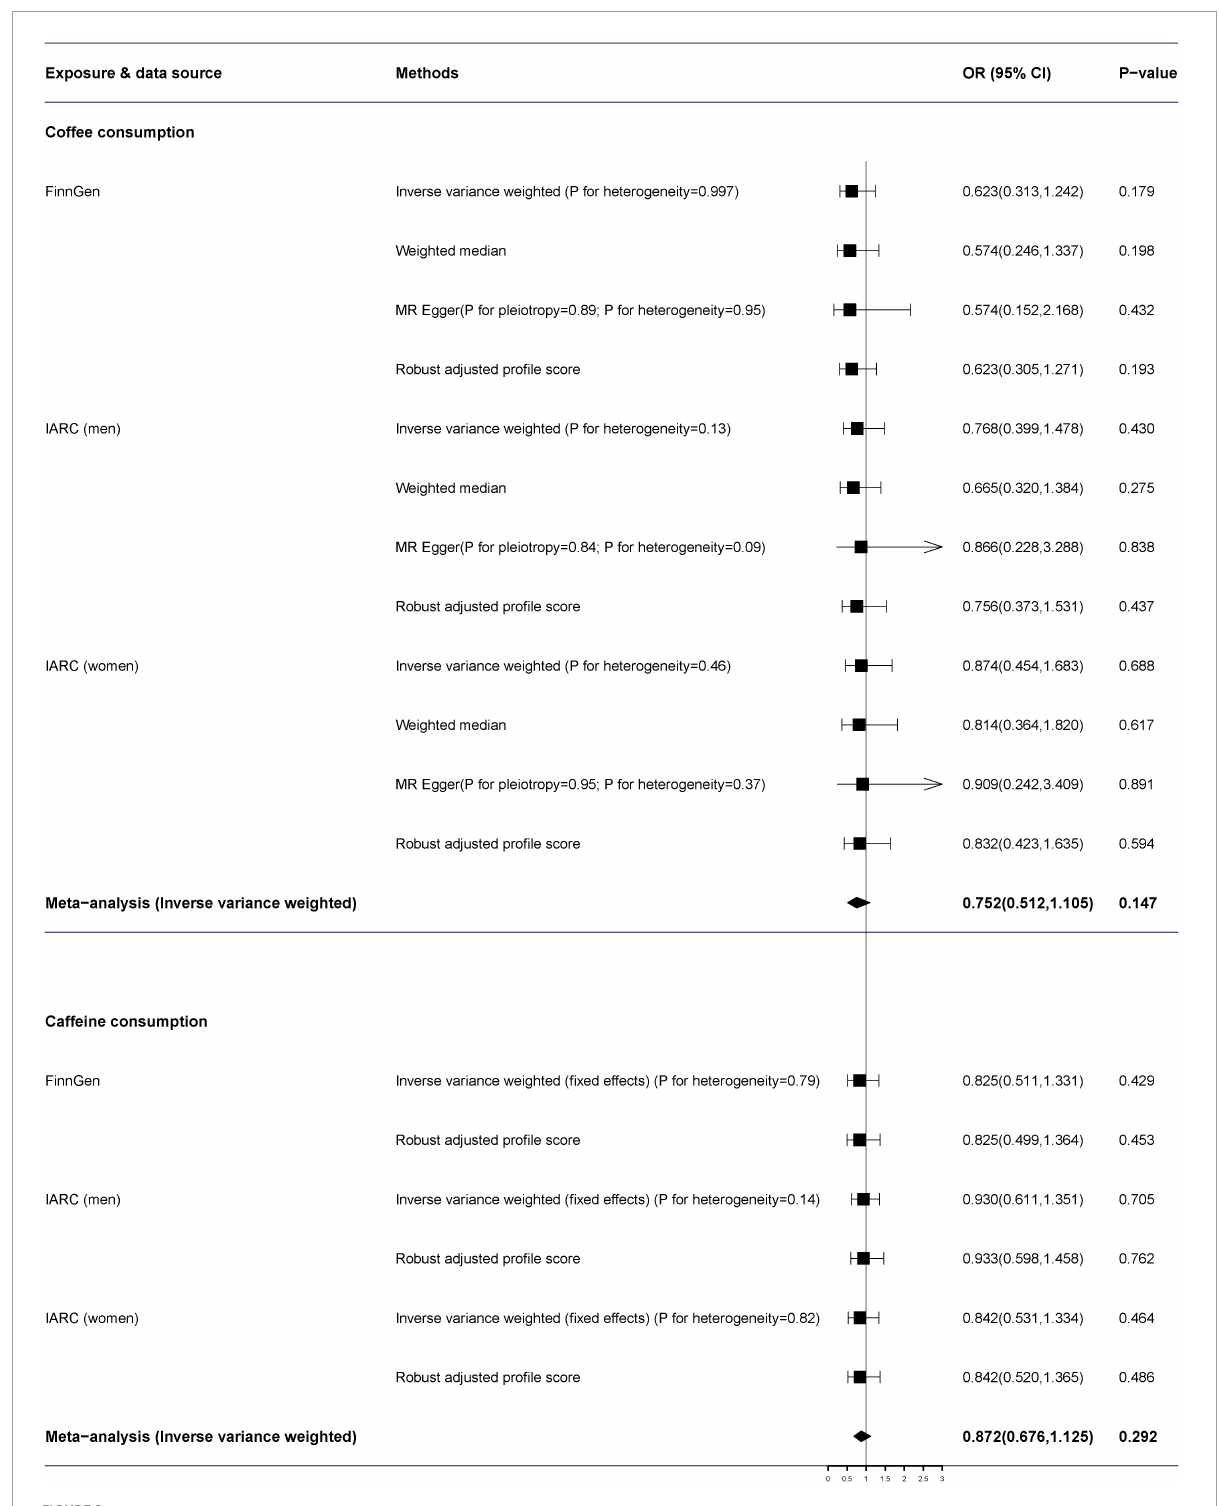
FIGURE2 The association of genetically predicted coffee and caffeine consumption with renal cell carcinoma. Pooled estimates were combined using the fixed-effects meta-analysis methods. ORs for renal cell carcinoma were scaled to a genetically predicted 50% of increase in coffee consumption and an 80-mg increase in caffeine consumption. FinnGen, FinnGen Consortium; IACC, the International Agency for Research on Cancer; OR , odds ratio; CI, confidence